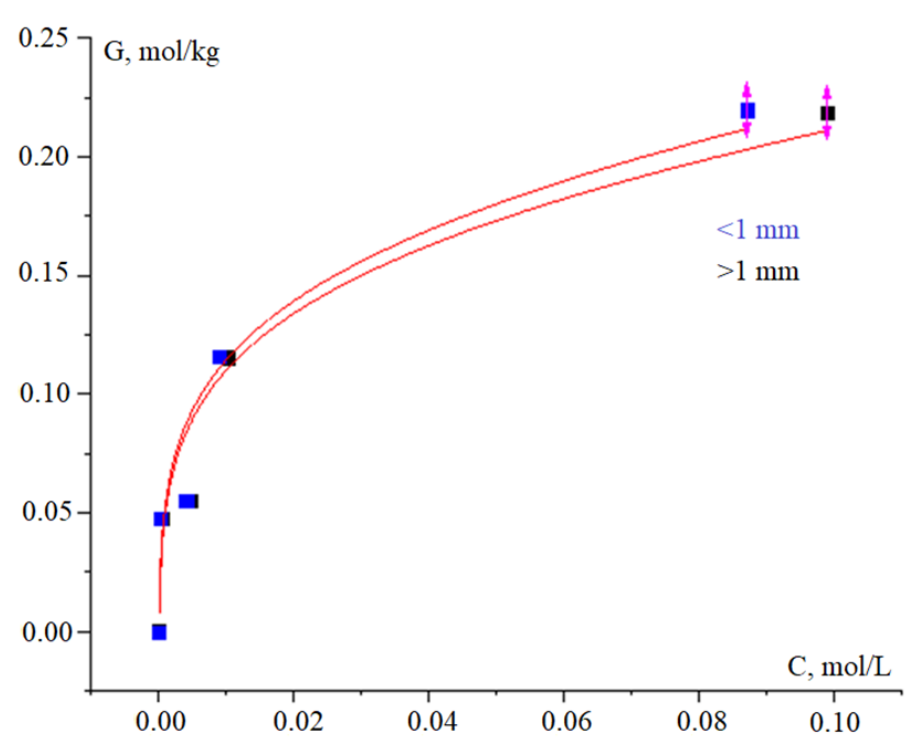
Figure 4. Isotherms of Mn 2 + sorption on organic material at a phase ratio of S:L = 1: 100, phase contact time of 2 h, temperature of 25 °C, 120 rpm.